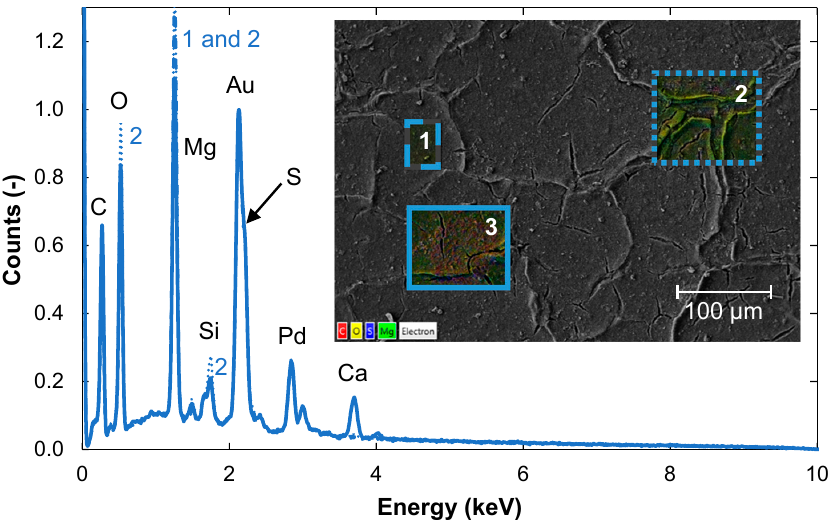
Figure 6. EDS spectrum from three areas (1 = solid line, 2 = dotted line, and 3 = dashed line) on a membrane sample that had been cleaned for 1 h. A SEM image of the membrane surface is shown in the insert. EDS analysis was carried out on the three areas indicated in the SEM image. The elements present and normalization are as described in Figure 2.